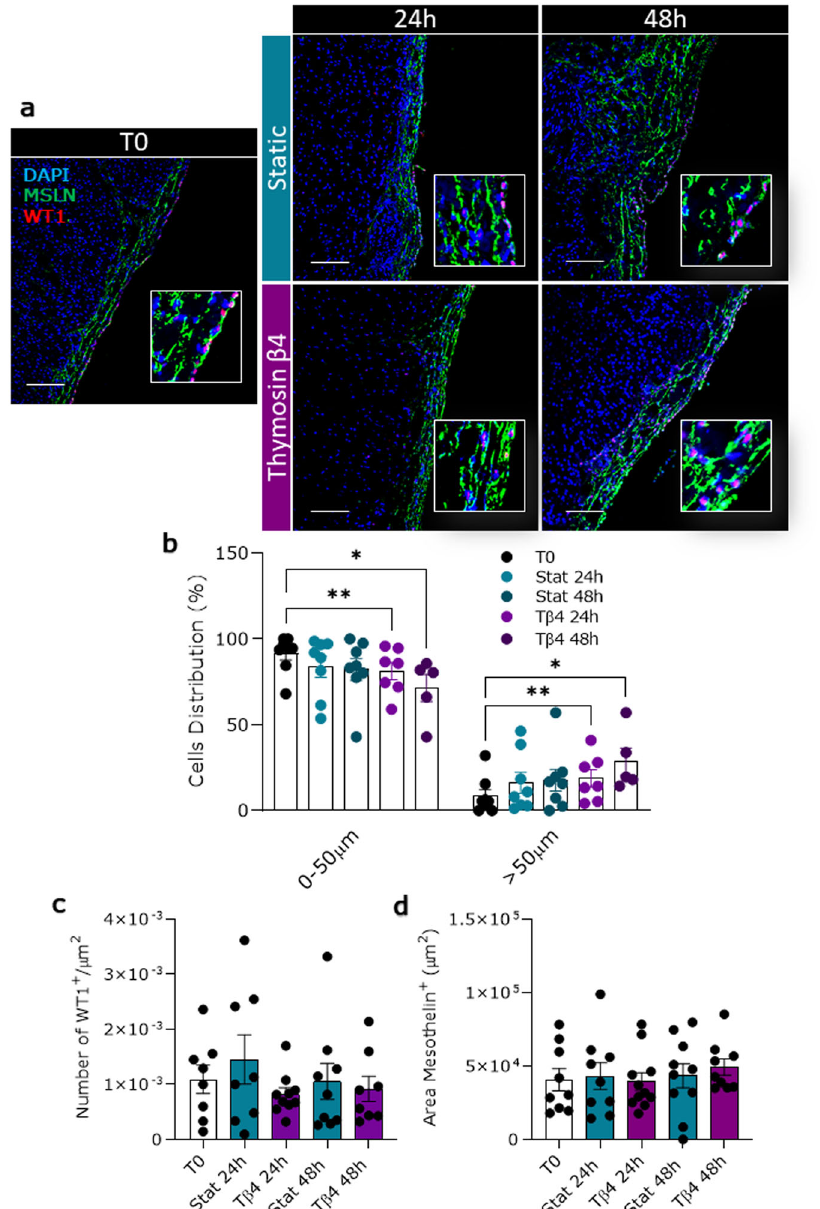
Fig. 11 T β 4 modi fi es WT1 + epicardial cell distribution in the sub-epicardial layer. WT1 + epicardial cells distribution evaluated as the average distance from the epicardial monolayer. Representative images of the distribution of WT1 and MSLN expression at different time points in freshly cut slices (T0) and after 24 and 48 h of control static (Stat) culture and thymosin β 4 (T β 4) treatment ( a ). Graph indicating the percentage of WT1 + cells retained in the epicardial layer (0 – 50 µm) or present in the area beneath the epicardium (>50 µm) in different culture conditions ( b ). Graph indicating the quanti fi cation of WT1 + cells in the whole slices ( c ). Graph indicating the area of mesothelin in the whole slice ( d ). N of pigs = 5 – 7, number of slices displayed in graphs. All graphs display data as mean ± SEM. * p ≤ 0.05, ** p ≤ 0.01. Scale bars, 100